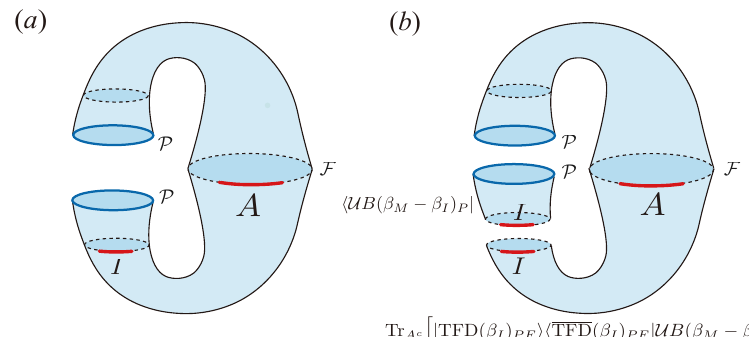
Figure 3 . ( a ) The geometry for the bulk transition matrix ρ Bulk gives the bra counter part. The entanglement island is present only at the ket part, so the time reflection symmetry is absent. ( b ) The bulk transition matrix on A ∪ I can be constructed in terms of thermofield double state and by projection onto the initial